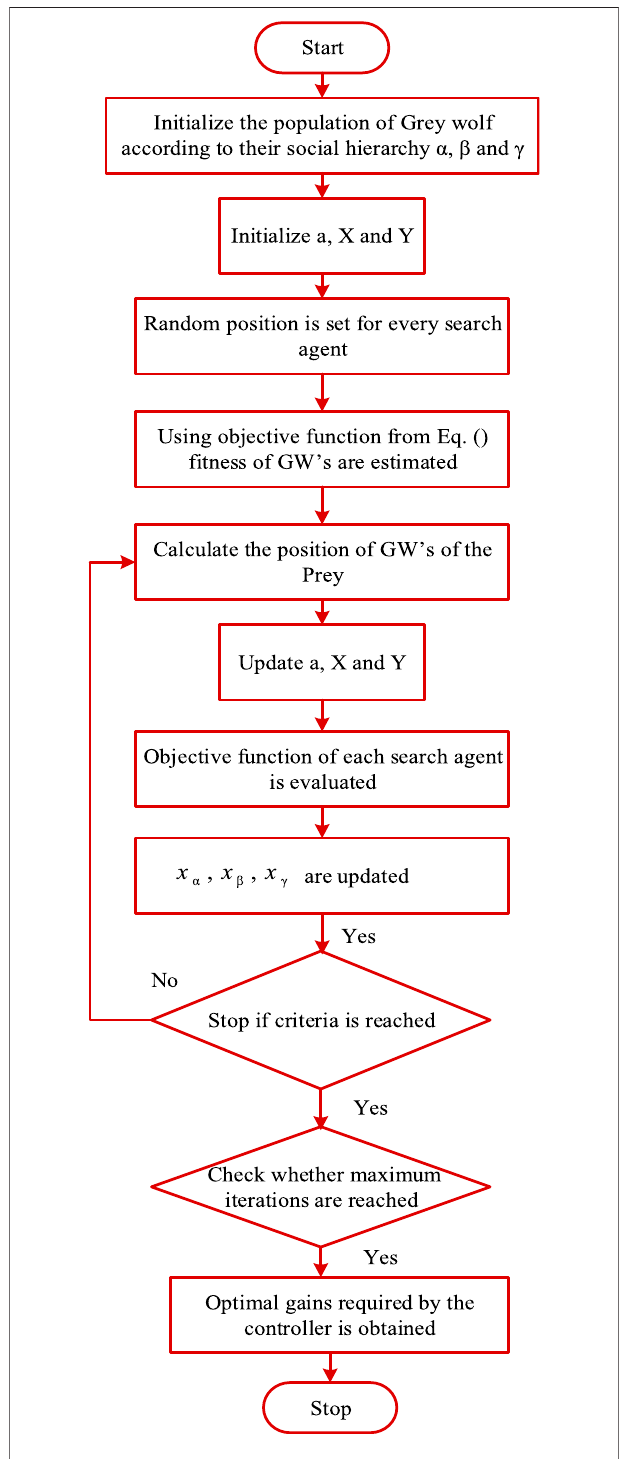
FIGURE 8 | Flow chart of GWO